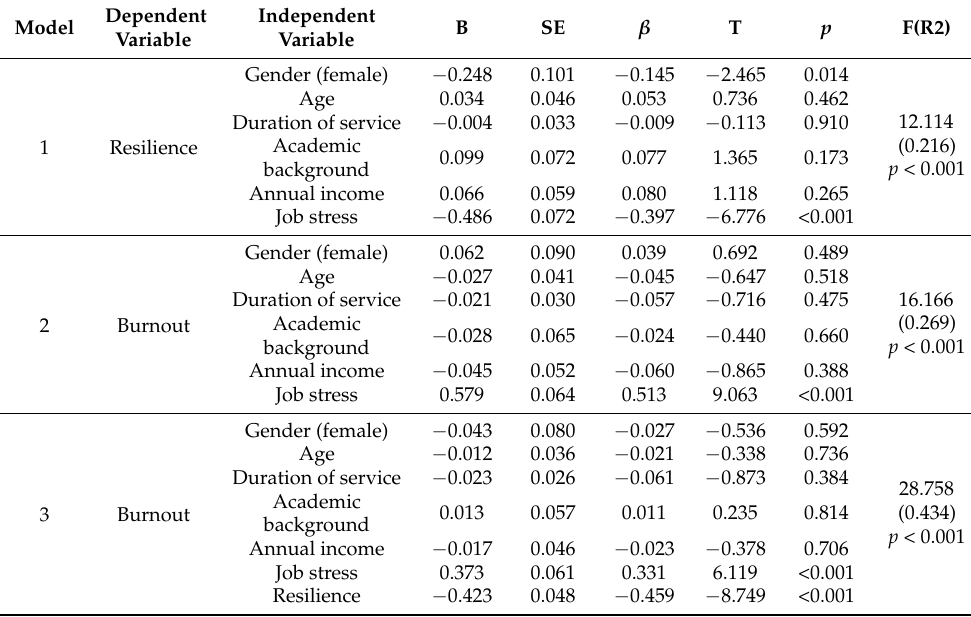
Table 3. Results of mediated effectiveness verification of